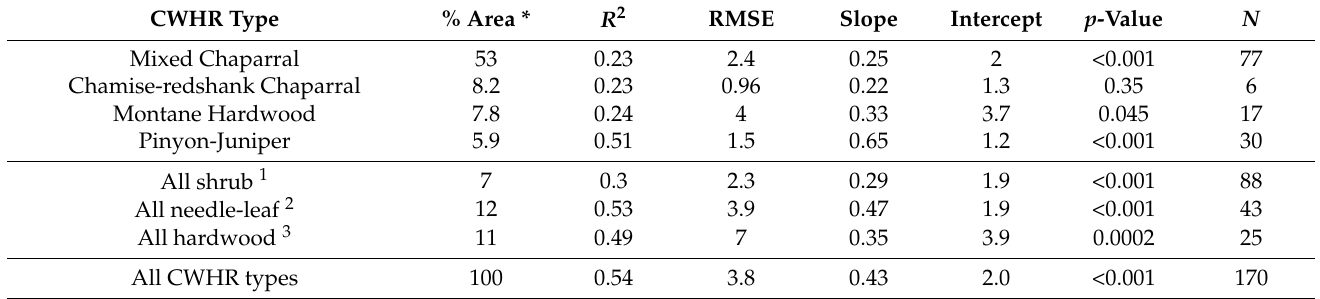
Table 3. Linear regression model statistics (WETAC-UCD estimates versus field estimates) for the validation plots by California Wildlife Habitat Relationships (CWHR) type [38]. Only those CWHR types that were 5% or greater of the USFS lands in the study area were